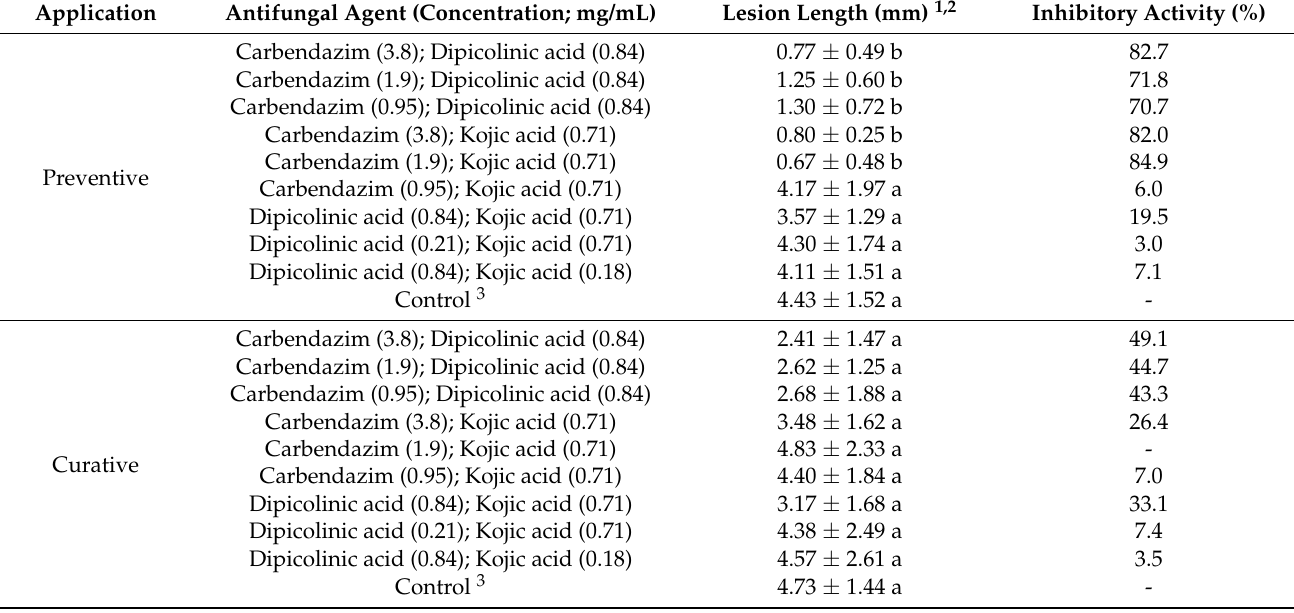
Table 2. Efficacy of carbendazim, dipicolinic acid and kojic acid combinations against Fusarium sulawense on soybean